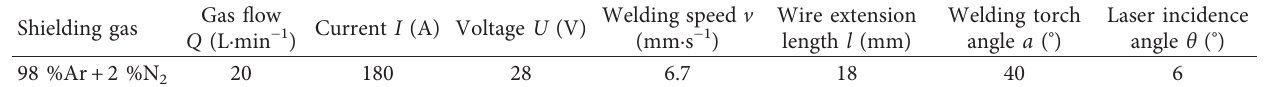
Table 1: Parameters of MAG welding.